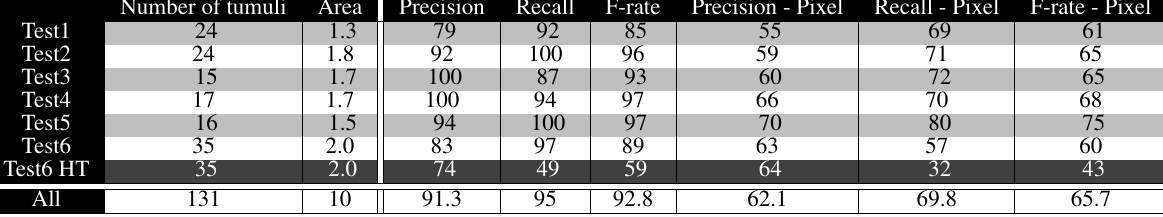
Table 1. Performance of our proposed Marked Point Process Model on six test data set indicated by F-rates (in %) . On the 6th test set, performance of Hough transform was also measured. Area of the test sets are given in hectares.